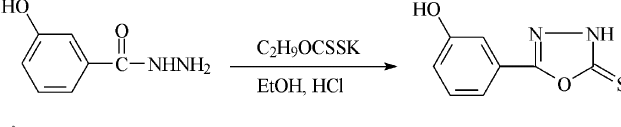
Figure 4 Synthetic scheme for the preparation of the title compound.